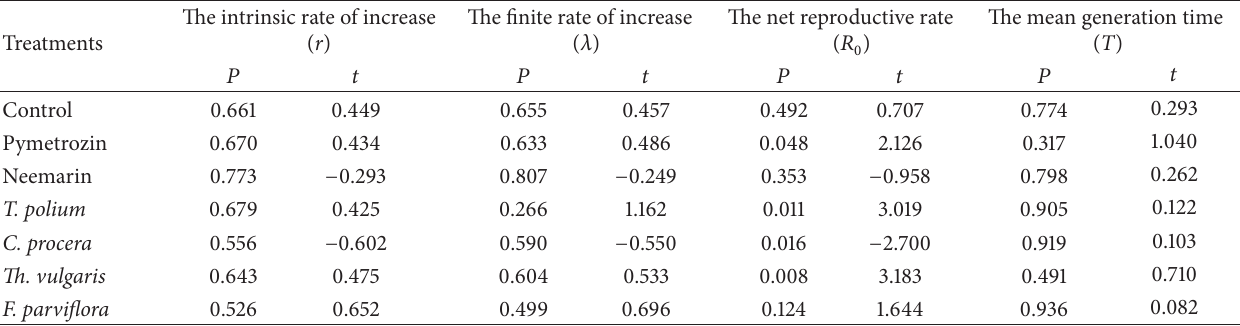
Table 3: Results of t -test analyses showing differences between the age-specific female life table and the age-stage two-sex life table in estimation of life table parameters of B. tabaci